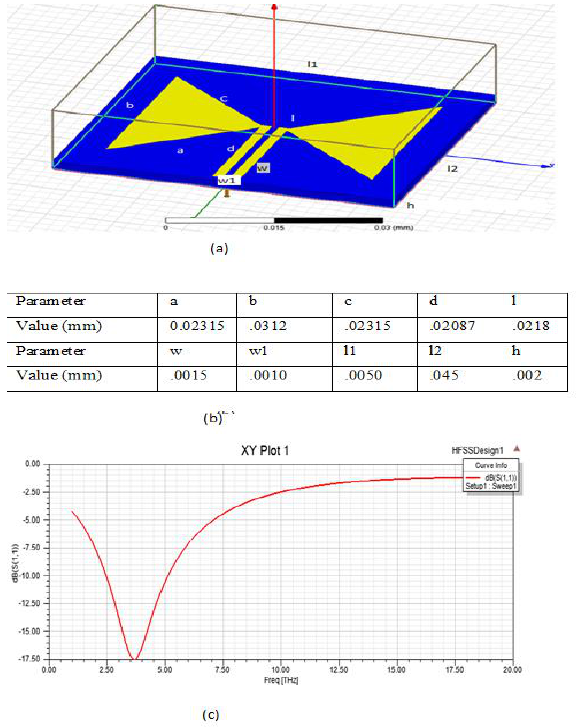
Figure 10: (a)Bow tie Graphene antenna on a SiO2 substrate,(b) dimensions in mm , (c)s11 parameter have second order nonlinear properties as regards polarization Vs electric field graph while Graphene patch with Si 𝑂 2 substrate is known to have third order nonlinear properties as